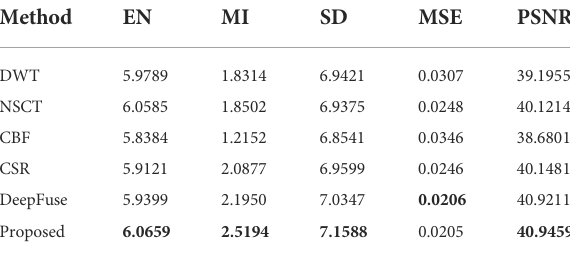
TABLE 3 Comparison results of evaluation metrics for